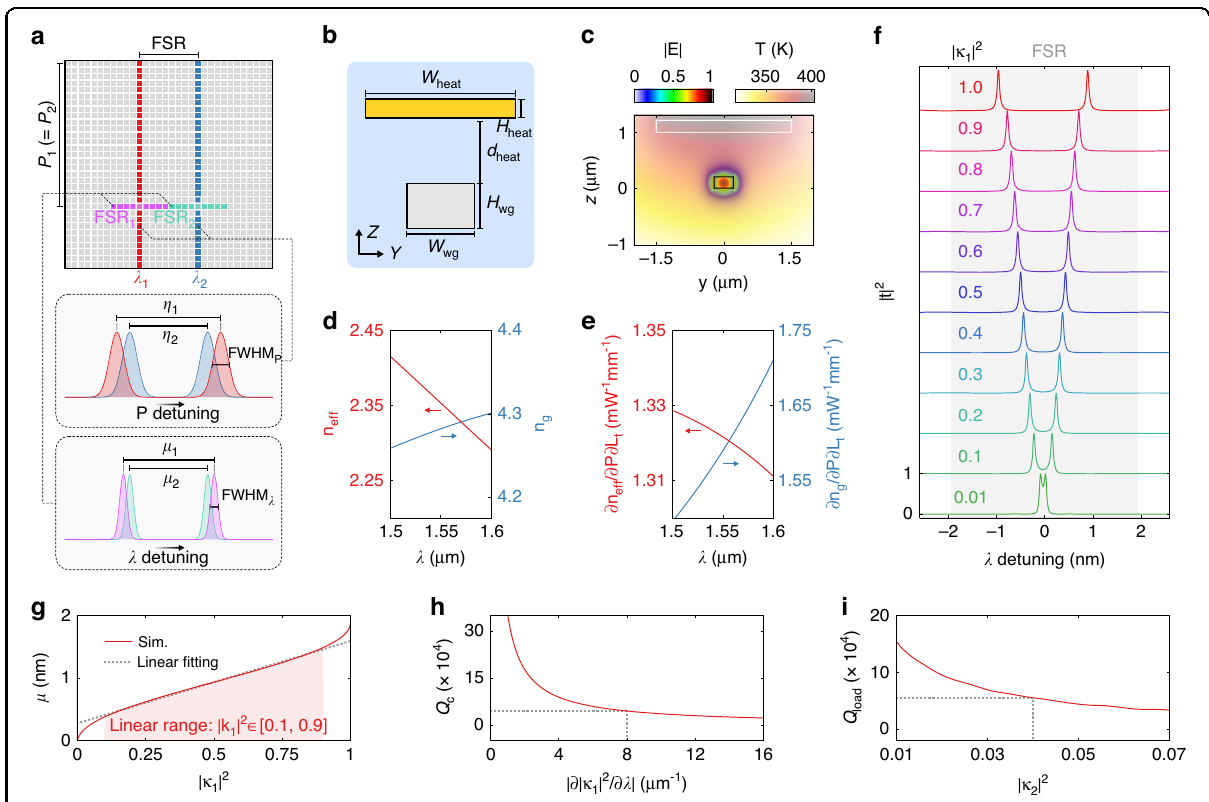
Fig. 2 Analysis of the photonic molecule. a Critical condition for the wavelength-channel decorrelation. b Schematic cross section of the waveguide with key parameters labeled. c Calculated TE 0 mode pro fi le (| E |) and temperature distribution ( T ). d Calculated effective indices ( n eff ) and group indices ( n g ) of TE 0 at varying wavelengths. e Calculated tuning coef fi cients ( ∂ n eff / ∂ P ∂ L t , ∂ n g / ∂ P ∂ L t ) at varying wavelengths. f Calculated transmission responses (| t | 2 ) of a photonic molecule with varying inter-resonator coupling strengths (| κ 1 | 2 ). g Calculated splitting strengths ( μ ) with varying | κ 1 | 2 . The dashed line represents the linear fi tting result. h Calculated critical Q factors ( Q c ) with varying coupling-strength dispersions (| ∂ | κ 1 | 2 / κ ∂ λ |). i Calculated loaded Q factors ( Q 2 ). The dashed lines indicate the optimal | ∂ | κ 2 / ∂ λ | and | κ load ) with varying external coupling strengths (| 2 | 1 | 2 |